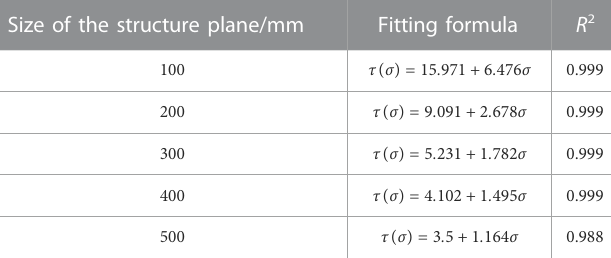
TABLE 4 Fitting relationships between SSSP and normal